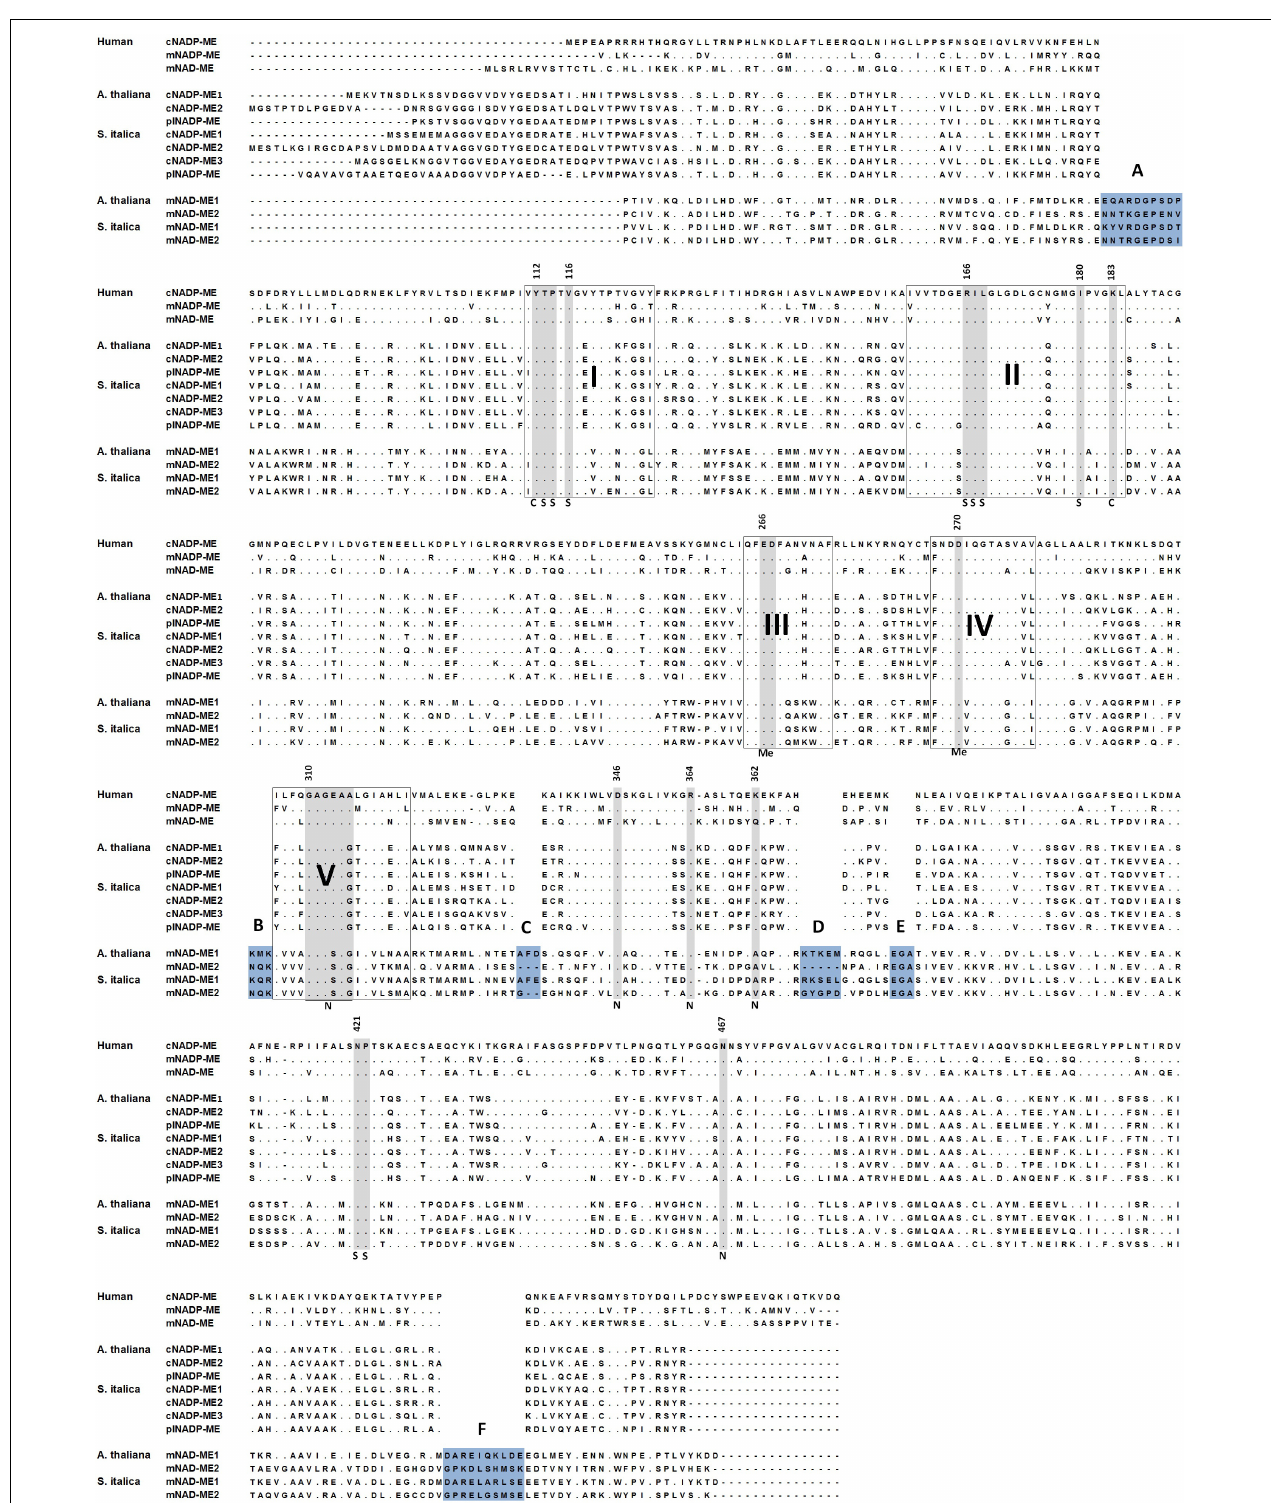
FIGURE 2 | Amino acid sequence alignment of representative NAD-MEs and NADP-MEs. NADP-ME and NAD-ME sequences of human, A. thaliana , and S. italica as representative of animal, eudicot plants, and monocot plants, respectively, are shown. Conserved sequences found in all NAD(P)-ME (sites I–V) are highlighted. Insertions present in plant mNAD-MEs are highlighted in blue. Amino acid residues implicated in catalysis (C) as well as in metal (Me), L -malate (S), or cofactor (N) binding are highlighted in gray. Numbers for each amino acid residue refer to their position in human mNAD-ME primary structure.